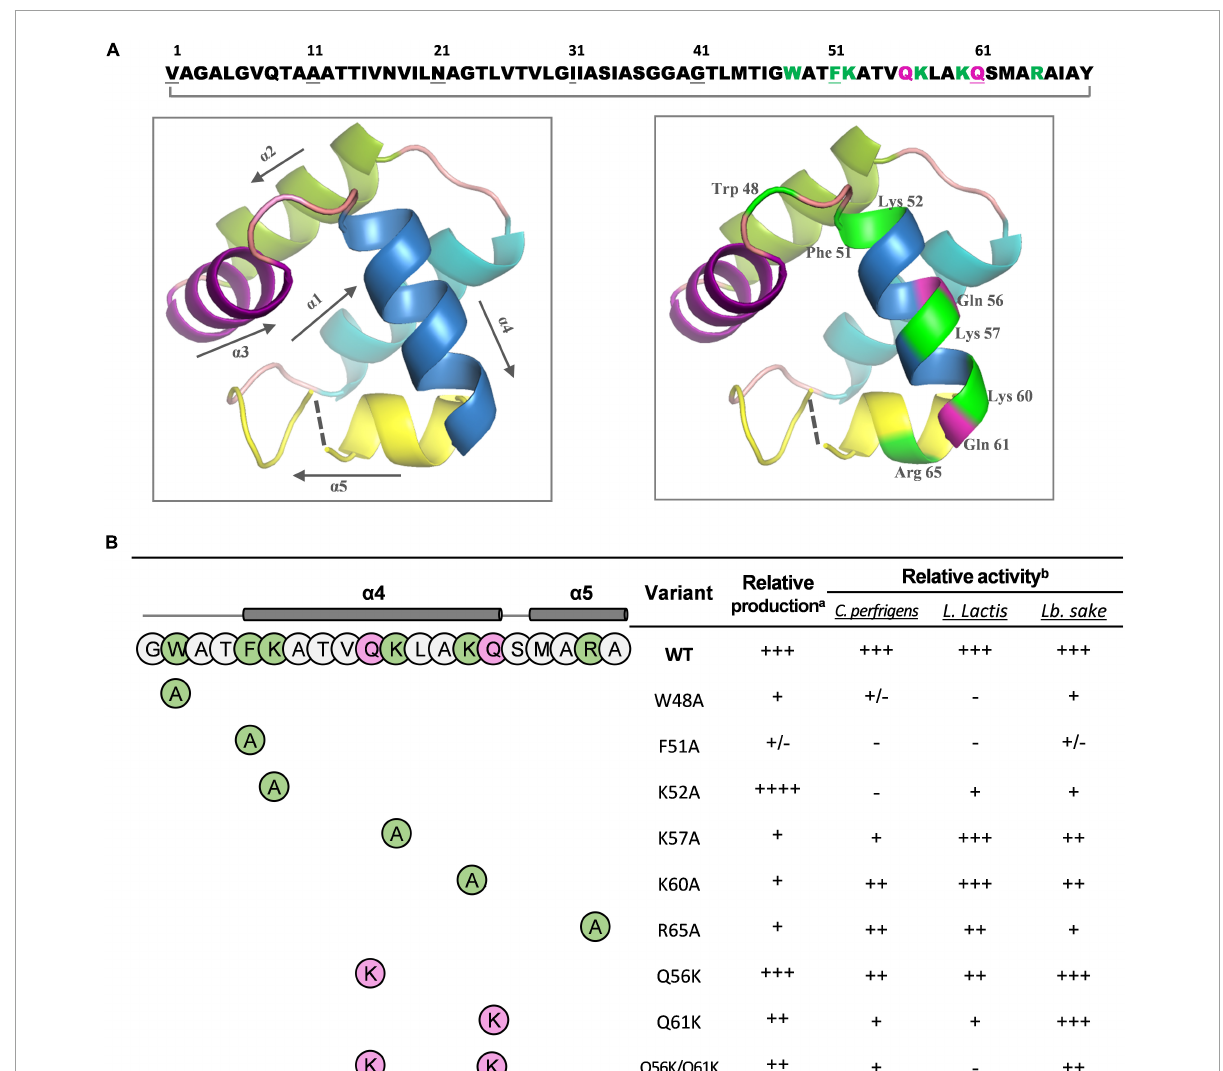
FIGURE4 The predicted structure and the mutagenensis study of circularin A. (A) The amino acid (aa) sequence and the predicted three-dimensional (3-D) structure of mature circularin A. The N- and C-termini are ligated between Val1 and Tyr69 to form the mature circular peptide. The aromatic and cationic residues are indicated in green and the glutamine residues subjected to mutagenesis are shown in magenta. The 3-D structure of circularin A with the layout of each α -helix and their orientations is shown on the left, and the mutagenesis location sites highlighted are shown on the right. (B) The structure/production/bioactivity relationships of circularin A and its variants against three different indicator strains: Clostridium perfringens , Lactococcus lactis NZ9000, and Lactobacillus sake ATCC 15521. The production and bioactivity of the wild-type (WT) circularin A were set as 100% (+++) and used for comparison. The relative production and bioactivity of its variants were evaluated with a scale of 0–2% (–), 2–20% (+/-), 20–50% (+), 50–80% (++), 80–100% (+++), > 100% (++++). a Relative production of the variants was estimated by band intensities in protein gel. b Relative activity of the variants was calculated by inhibition area in the colony overlay